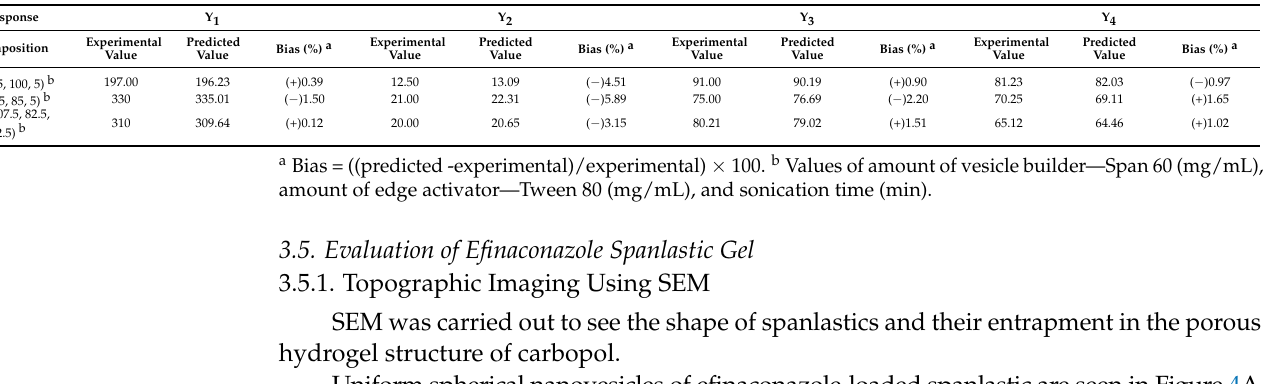
Table 7. The validation batches and the prediction error calculated as bias a (%).